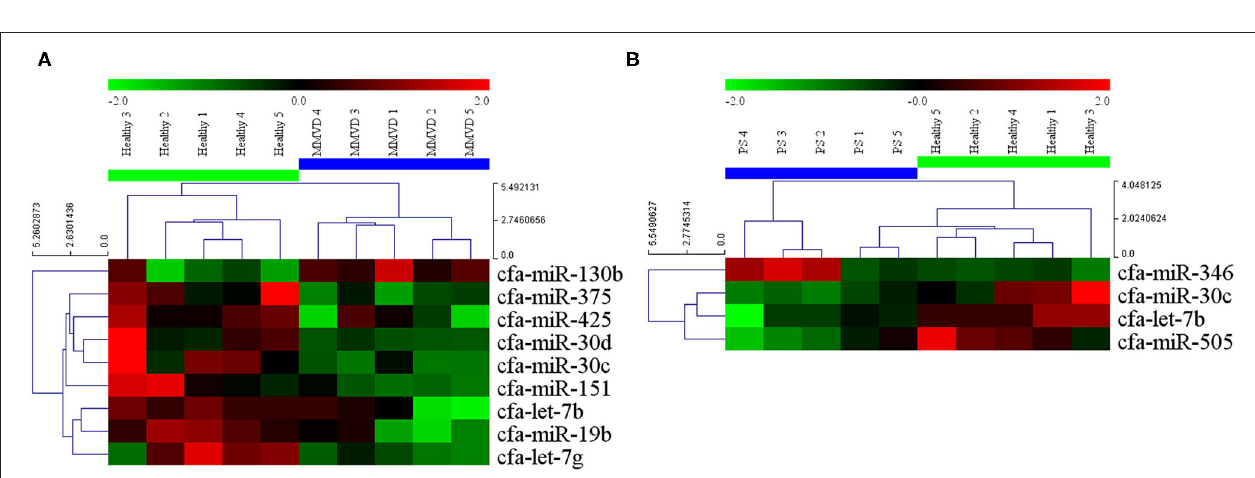
FIGURE 2 | Volcano plots of circulating miRNA in dogs with (A) MMVD or (B) PS, compared with healthy dogs. The volcano plot shows the fold change and p -value between the dogs with heart diseases and healthy dogs for 291 miRNAs. The vertical lines correspond to a 1.5-fold differences, and the horizontal line displayed a p -value of 0.05. Therefore, the blue and red points in the plot represent the miRNAs with statistically significant differential expression in dogs with MMVD or PS (A or B, respectively) compared with healthy dogs. miRNA, microRNA; MMVD, myxomatous mitral valve degeneration; PS, pulmonic stenosis.